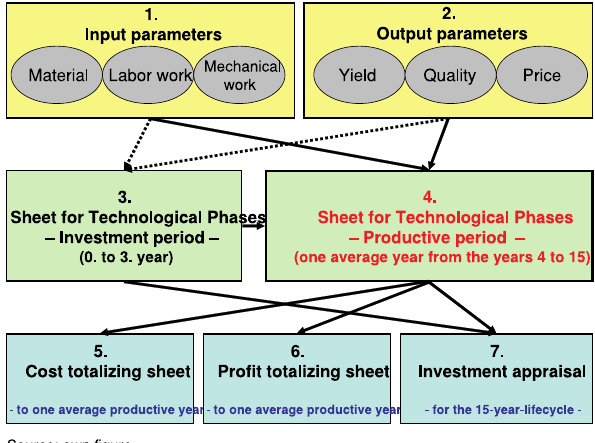
Figure 2 . Structure of the Farm Business